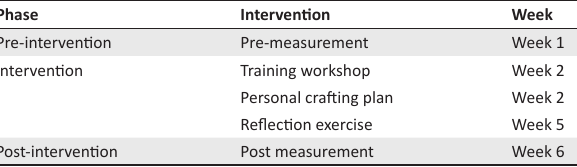
TABLE 1: Overview of the job-crafting intervention